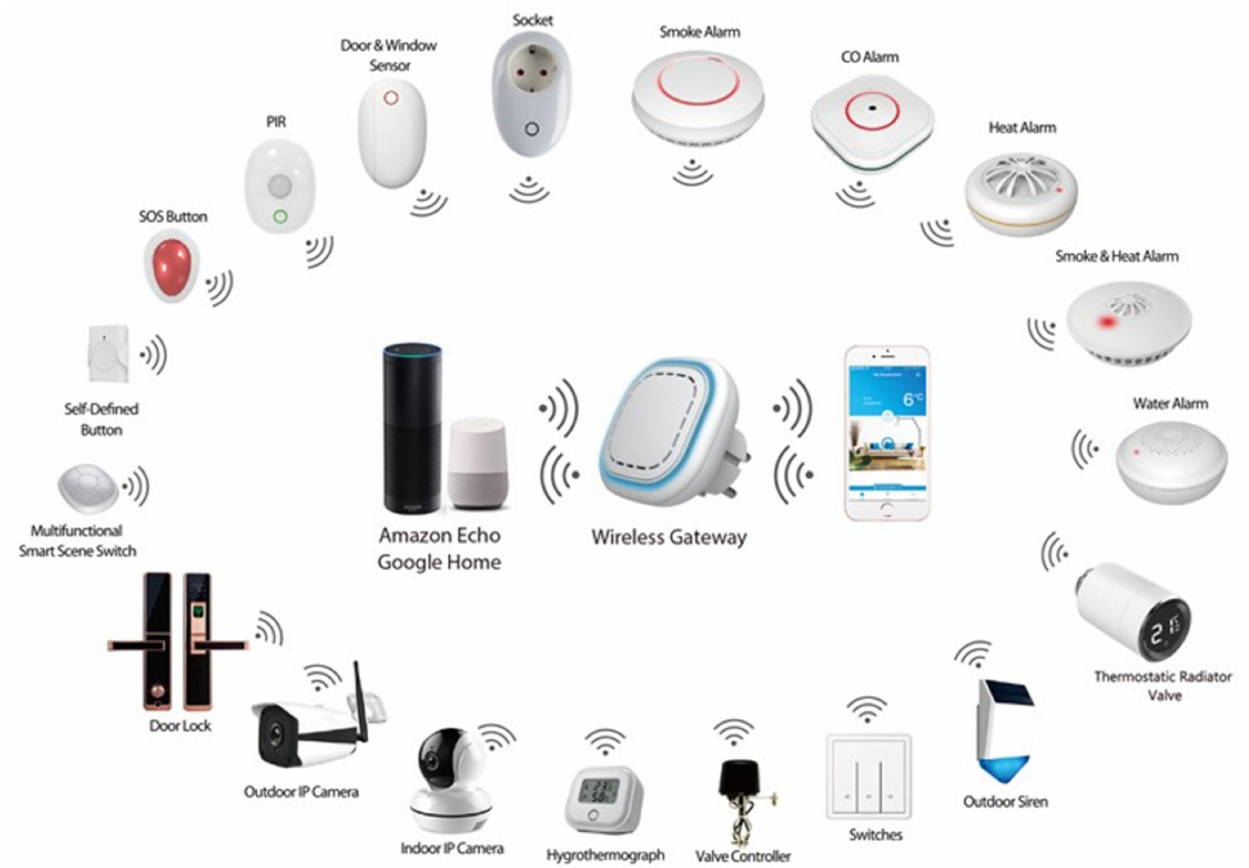
Figure 4. Big data generators in smart